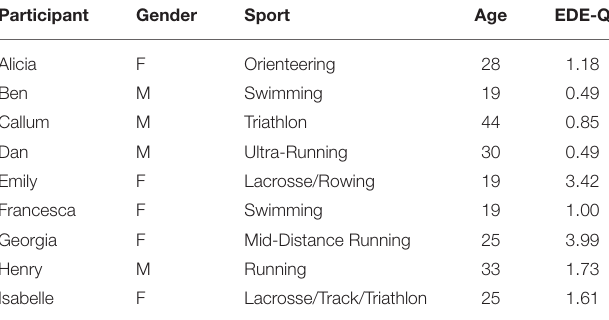
TABLE 1 | Participant information.